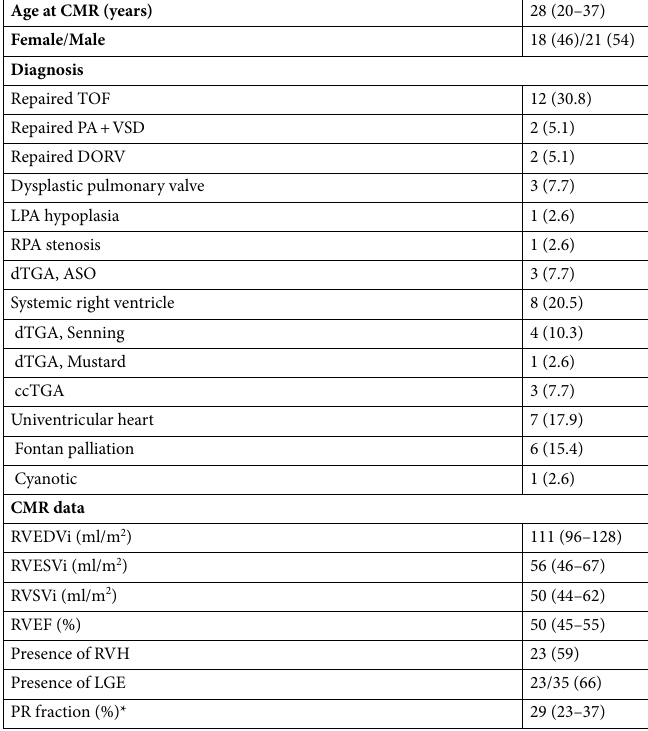
Table 2. Patient characteristics (n = 39). Values are given as median (range) or n (%). *PR fraction determined in patients with repaired TOF, PA + VSD and DORV, and dysplastic pulmonary valve. ASO = arterial switch operation; ccTGA = congenitally corrected transposition of the great arteries; CMR = cardiovascular magnetic resonance; DORV = double outlet right ventricle; dTGA = d-transposition of the great arteries; LGE = late gadolinium enhancement; LPA = left pulmonary artery; PA + VSD = pulmonary atresia with ventricular septal defect; PR = pulmonary regurgitation; RPA = right pulmonary artery; RVEDVi = indexed right ventricular end-diastolic volume; RVEF = right ventricular ejection fraction; RVESVi = indexed right ventricular end- systolic volume; RVH = right ventricular hypertrophy; RVSVi = indexed right ventricular stroke volume; TOF = tetralogy of